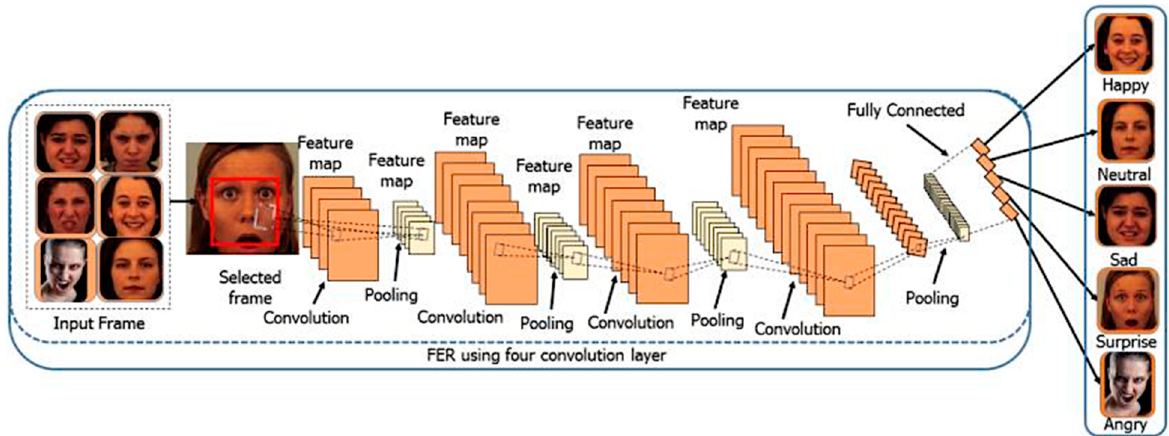
Figure 2. Training process of CNN model for facial emotion recognition.